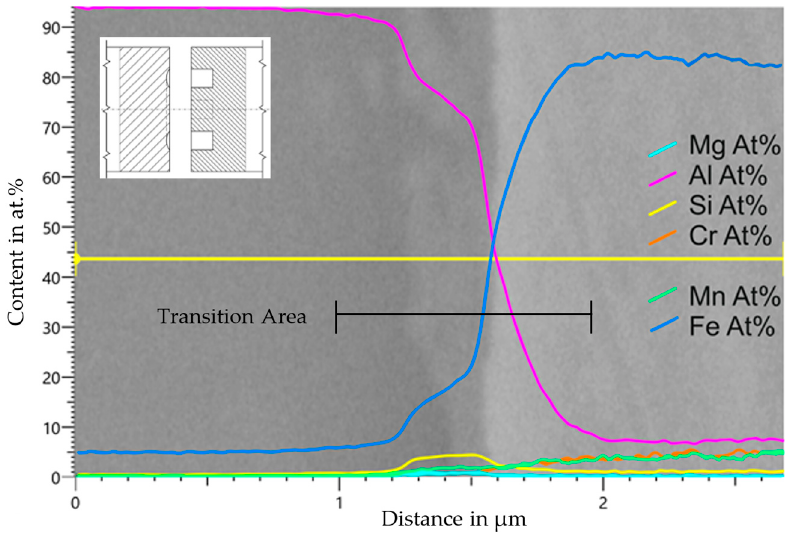
Figure 15. Energy-dispersive X-ray spectroscopy (EDS) analysis of the transition area in a specimen of Geometry C, SEM image of the recording line (yellow), Electron High Tension (EHT) = 12 kV, probe current = 1.7 nA, and working distance = 4.9 mm.